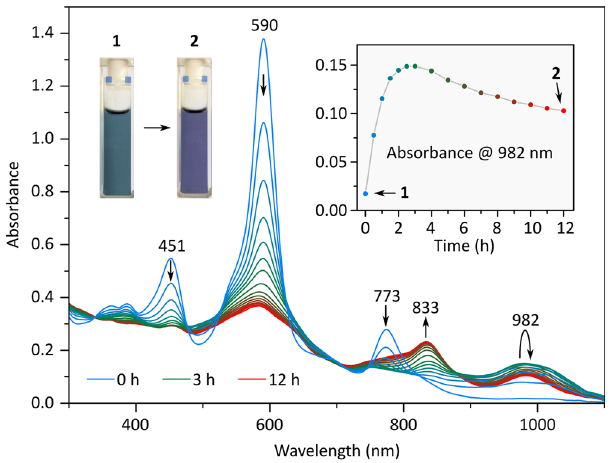
Fig. 4 Changes of UV-vis-NIR absorption spectra occurring during photoirradiation of 1. Blue: initial spectrum of 1 (0.01 mM in toluene, room temperature); green: intermediate photooxidation state with maximum intensity at 982 nm ( t = 3 h); red: fi nal absorption spectrum of 2 ( t = 12 h). Spectra were recorded every 1 h.